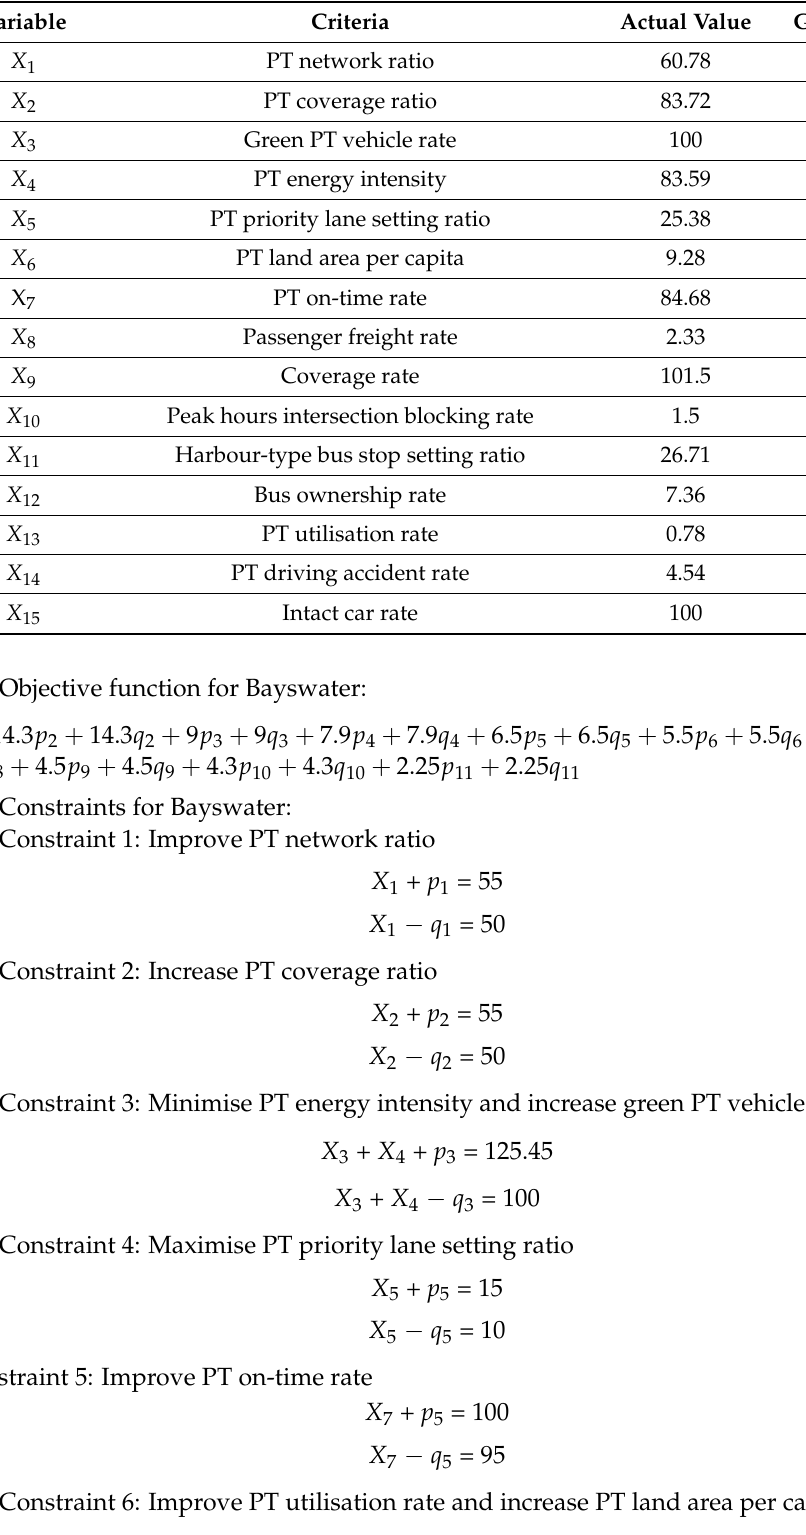
Table 3. Stonnington’s actual and goal values for decision